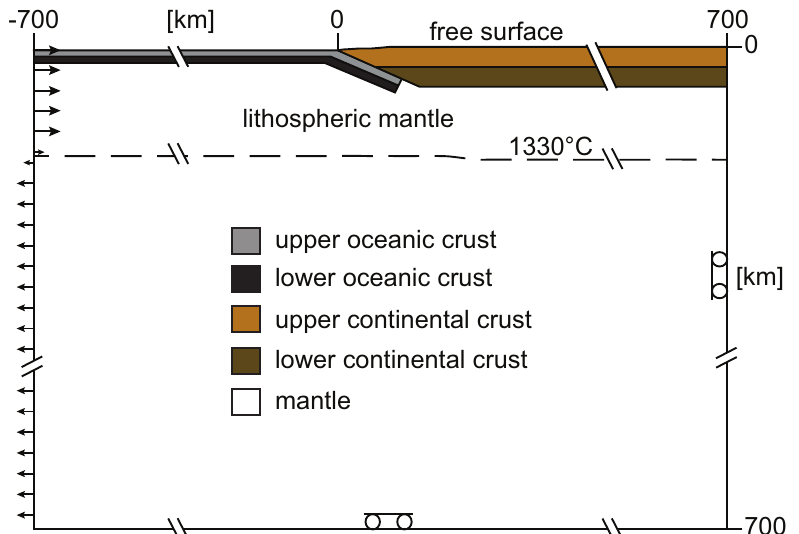
Figure 10. Model setup. The model domain is 1400 km wide and 700 km deep. The lithosphere thickness is defined by the 1330 ◦ C isotherm. The velocity boundary conditions correspond to a free-slip condition along the bottom and the right boundaries of the domain. An inflow velocity of 3 cm/yr is fixed along the left boundary throughout the lithosphere and an outflow velocity is fixed up to the bottom to balance the flux. The upper boundary is treated as a free surface. The materials included in the model account for the upper and lower oceanic crust, upper and lower continental crust, and mantle (see Table 4 for material parameters and